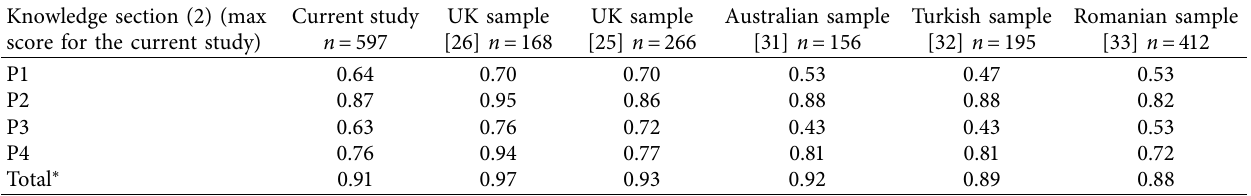
Table 1: A comparison of the internal reliability of the current study with the results of questionnaires developed in other studies. Knowledge section (2) (max